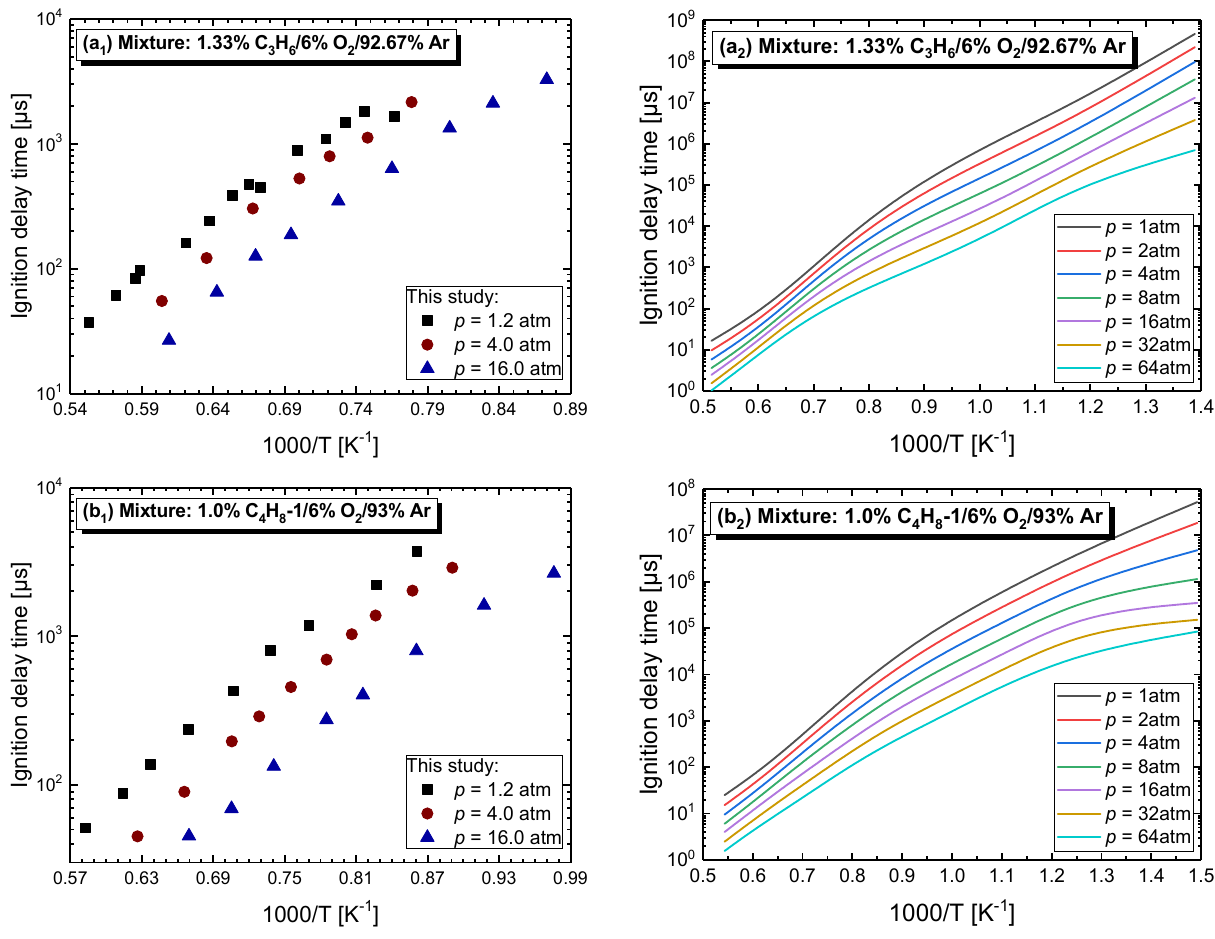
Figure 12. Quasi-linear pressure dependence of IDTs of propene and 1-butene. ( a 1 )/( a 2 ) propene; ( b 1 )/( b 2 ) 1-butene. Sym- bols are experimental IDTs from this study; lines are results simulated by NUIGMech 1.1.